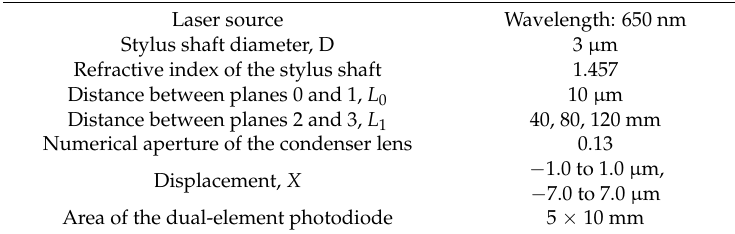
Table 1. Simulation conditions.